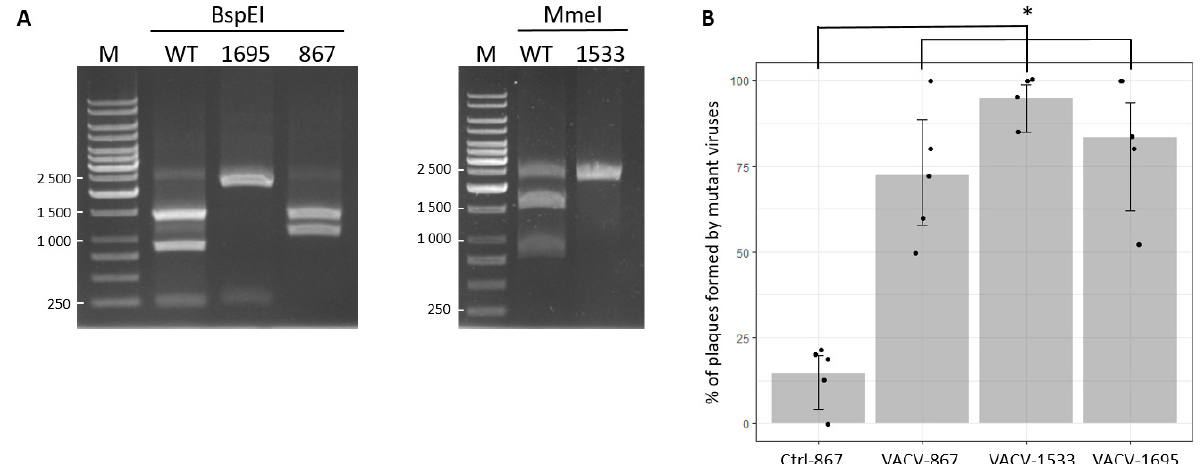
Figure 2. Efficient mutagenesis of the VACV genome using CRISPR/Cas9. ( A ) Agarose gel electrophoretic restriction fragment patterns obtained after PCR amplification of a 2415-bp-long fragment of E9L (Table 1) and digestion with BspEI or MmeI. BspEI digestion of WT E9L produced three fragments (1361 bp, 828 bp, and 226 bp). Two fragments of 2189 bp and 226 bp were obtained for E9L 1695, as well as for E9L 867 (1361 bp and 1054 bp). The 2415-nucleotide-long WT E9L PCR was only partially digested by MmeI, and produced three fragments of 1548 bp, 777 bp, and 90 bp (not shown). Two fragments of 2325 bp and 90 bp (not shown) were obtained for E9L 1533. Lane M: DNA size standard (GeneRuler 1 kb, Thermo Fisher Scientific). The sizes of the relevant bands are indicated in bp. ( B ) Percentage of plaques formed by mutant viruses. Mutant viruses were identified by restriction pattern analysis, as shown in panel ( A ). Results are presented from five independent experiments (except for mutant 1533, four experiments) for which 15/20 plaques were isolated and analyzed as described above (data are shown as the mean ± standard deviation). * Indicates p < 0.05 compared to Ctrl-867 group (using resampling tests for intergroup